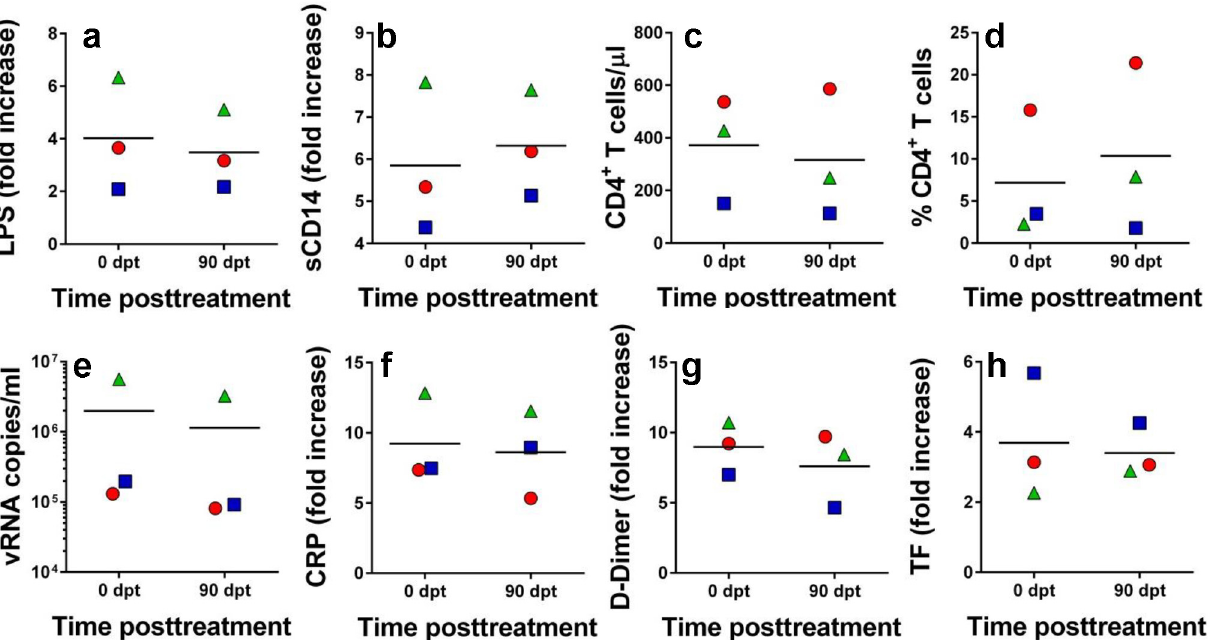
Fig 7. Rifaximin (RFX) + sulfasalazine (SFZ) therapy have no impact on the natural history of SIVsab infection in chronically SIVsab-infected pigtailed macaques. Combination RFX+SFZ therapy did not impact microbial translocation, as illustrated by the plasma levels of LPS (a) or sCD14 (b), peripheral CD4 + T cell counts (c), mucosal CD4 + T cell levels (d), viral replication (e), inflammation (C-reactive protein) (f) or coagulation, as illustrated by the levels of D-dimer (g) and tissue factor (h). The fold increases from the preinfection levels of the tested biomarkers are shown. Treatment was initiated at 170 days after SIV infection, when biomarkers were already increased from the preinfection baseline. A therapeutic effect at the end of treatment (90 dpt) would have been illustrated by normalization of the increases from the baseline observed at treatment initiation (0 dpt).